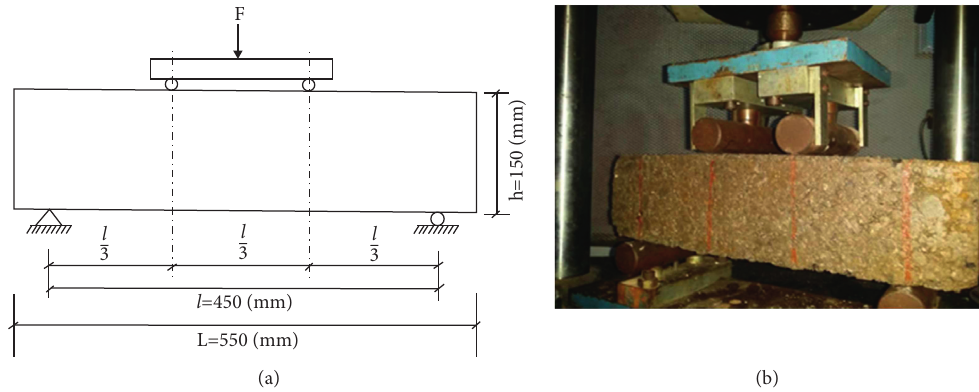
Figure 2: Flexural strength test setup. (a) Schematic diagram. (b) Test